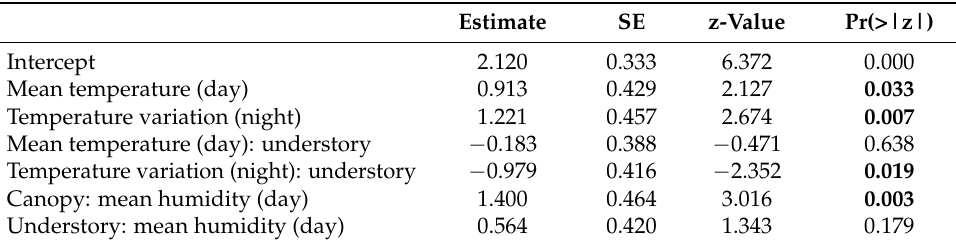
Temperature variation (night): understory − 0.979 Canopy: mean humidity